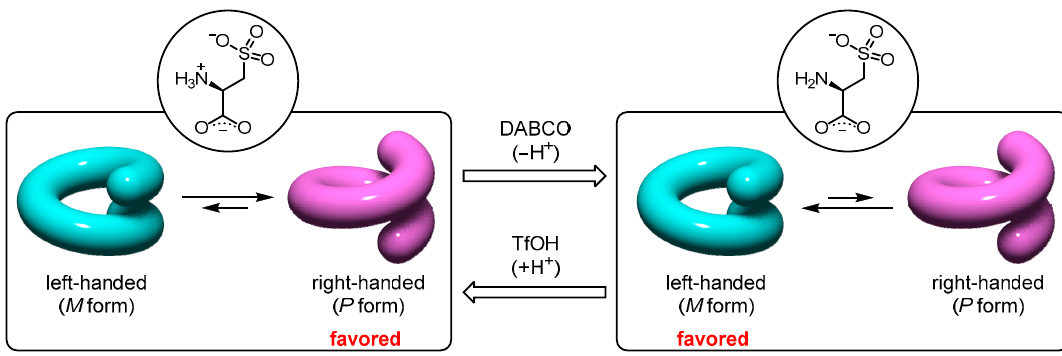
Figure 9. Responsive helicity inversion observed in the L 2 Zn 3 La/cysteic acid system driven by protonation/deprotonation.